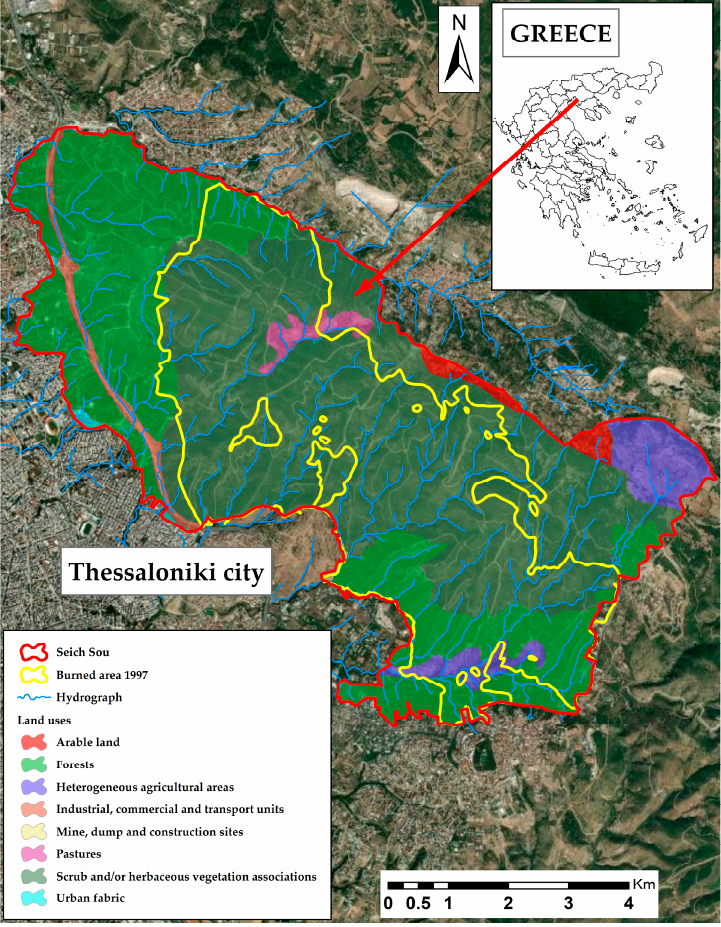
Figure 6. Land uses in the study area according to the Corine Land Cover